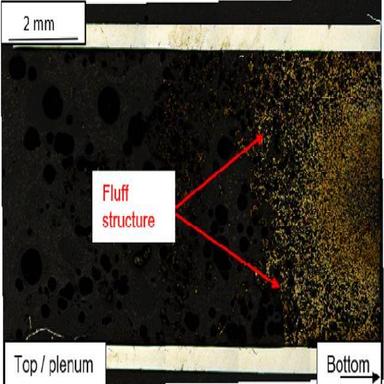
Back-scatter electron imaging of X501-G591 sample cross section from showing also the different regions discussed in the text and described more in details in e